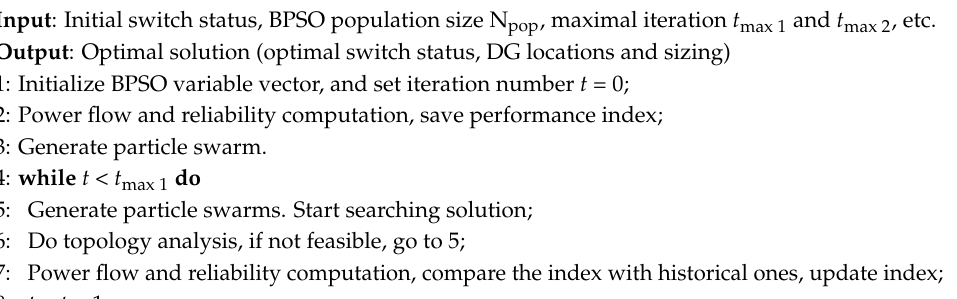
Algorithm 1. Procedures of the proposed BPSO &